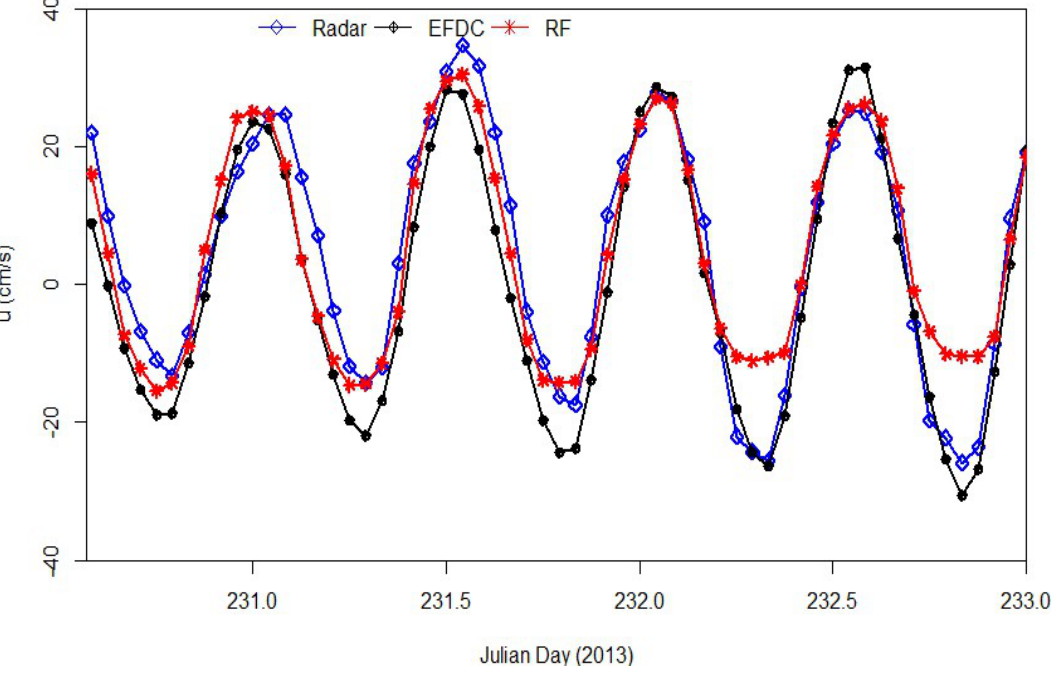
Figure 8. Predictions of meridional surface velocity component at point P3. Figure 7. Predictions of zonal surface velocity component at point P3. J. Mar. Sci. Eng. 2019 , 7 , x FOR PEER REVIEW